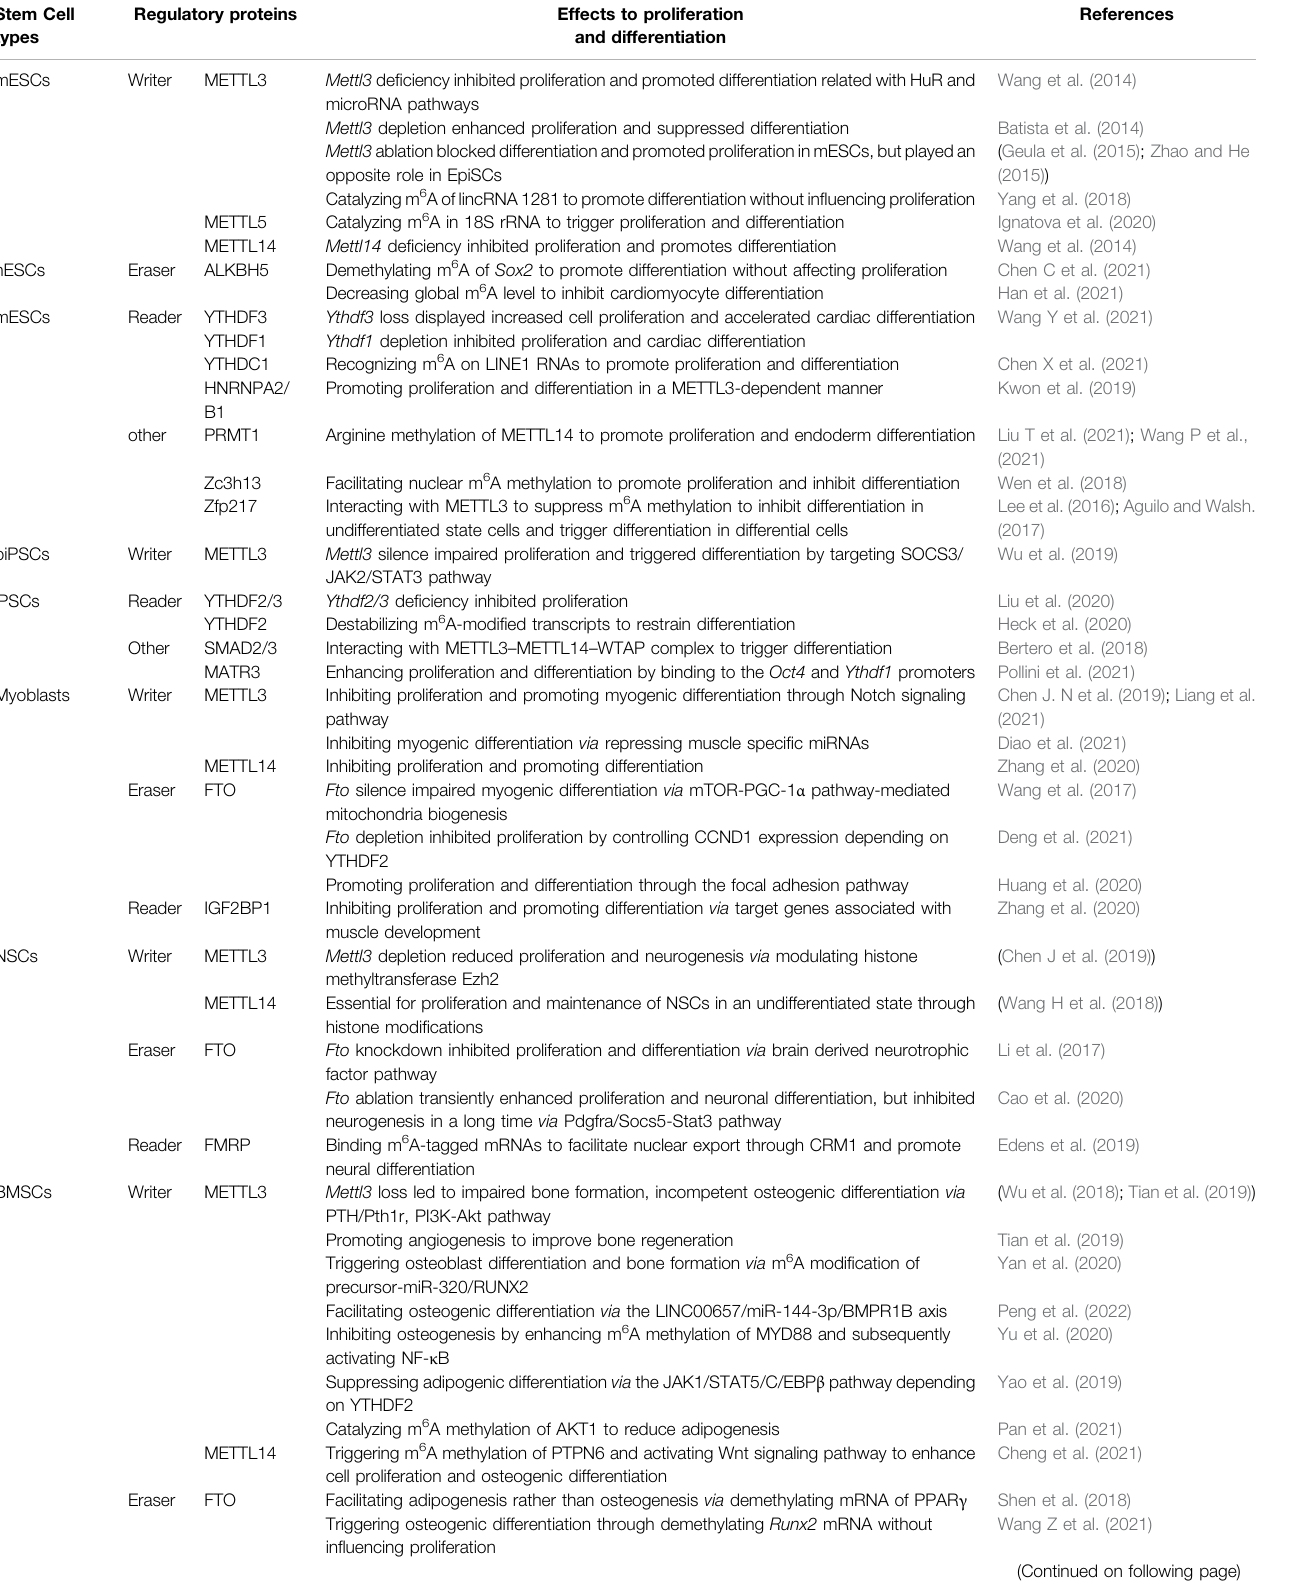
TABLE 1 | RNA methylation regulators and their functions in different types of stem